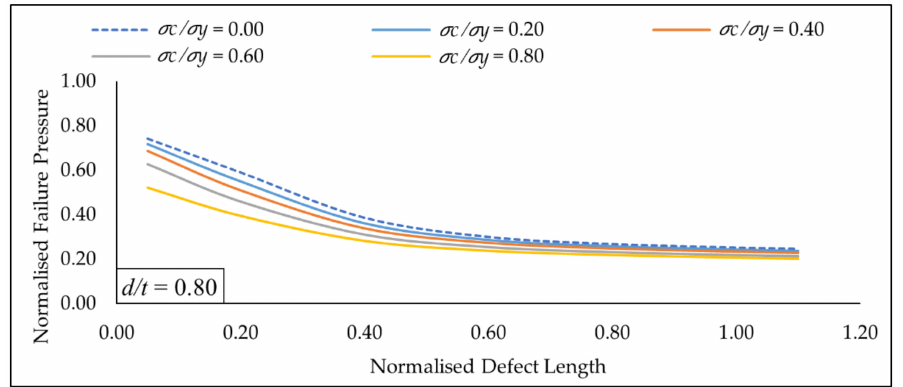
Figure 17. Normalized failure pressure predictions of the new assessment method against various normalized defect length for multiple axial compressive stress at a constant normalized defect depth of